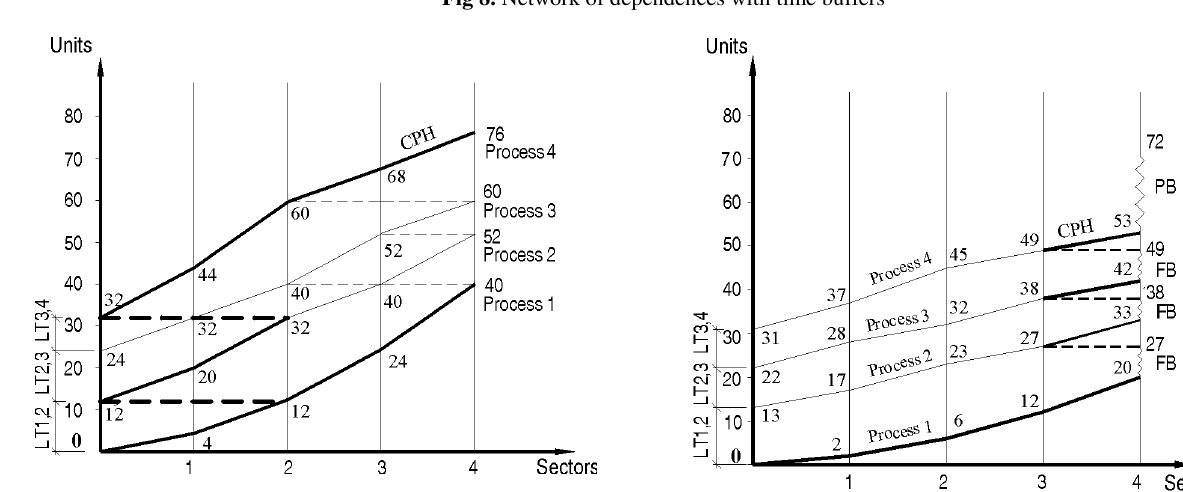
Fig 8. Network of dependences with time buffers